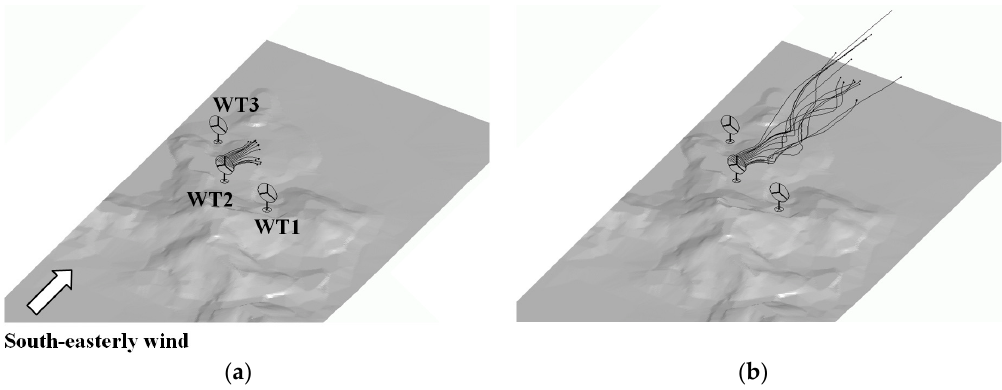
Figure 14. Trajectories (pathlines) of virtual particles released from the location of WT2. Virtual particles are released at the height of the center of the wind turbine hub, across a straight line between the left and right ends of the swept area. ( a ) At non-dimensional time, t. ( b ) At non-dimensional time, t + ∆ t.